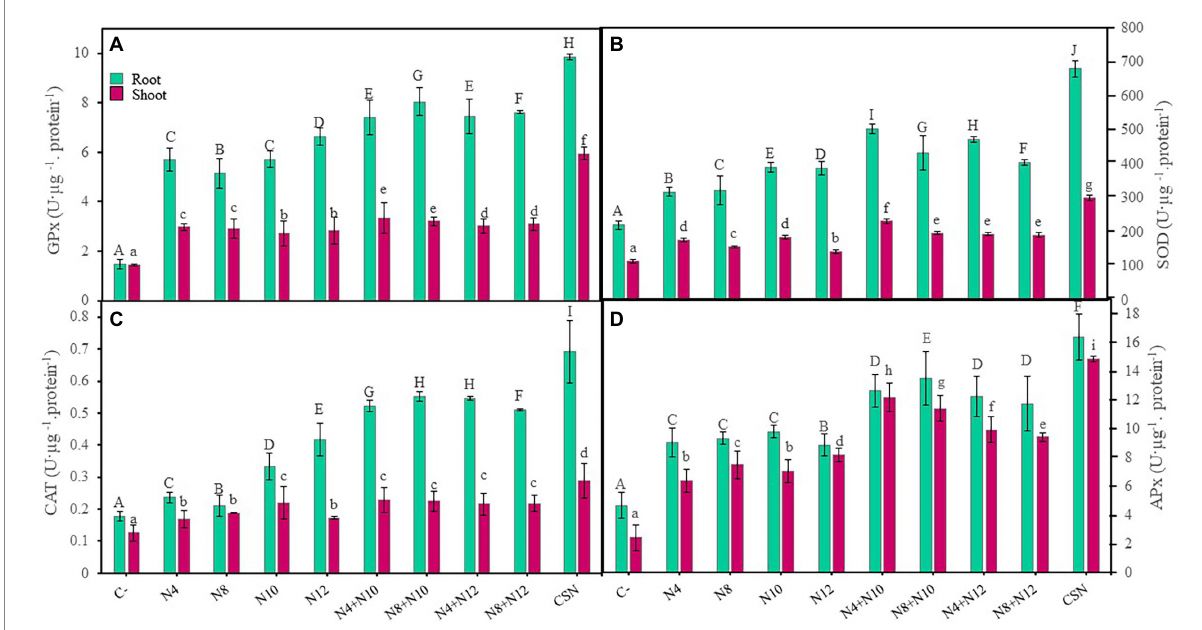
FIGURE 5 Antioxidant enzymes in M. sativa plants inoculated with PGPNE. (A) Guaiacol peroxidase, (B) superoxide dismutase, (C) catalase, and (D) ascorbate peroxidase activities after 60 days in pots containing soil from the high marshes of the Odiel River. Values are means ± S.D. ( n = 16). Different letters indicate statistical differences between means. Lowercase and uppercase letters are used to qualify different variables and are not comparable among them (One-way ANOVA; LSD test, p < 0.001). C-: non inoculation; N4: inoculation with Pseudomonas sp. N4; N8: inoculation with Pseudomonas sp. N8; N10: inoculation with Ensifer sp. N10; N12: inoculation with Ensifer sp. N12; N4 + N10: co-inoculation with Pseudomonas sp. N4 and Ensifer sp. N10; N8 + N10: co-inoculation with Pseudomonas sp. N8 and Ensifer sp. N10; N4 + N12: co-inoculation with Pseudomonas sp. N4 and Ensifer sp. N12; N8 + N12: co-inoculation with Pseudomonas sp. N8 and Ensifer sp. N12; CSN: inoculation with Pseudomonas sp. N4, Pseudomonas sp. N8, Ensifer sp. N10 and Ensifer sp. N12.